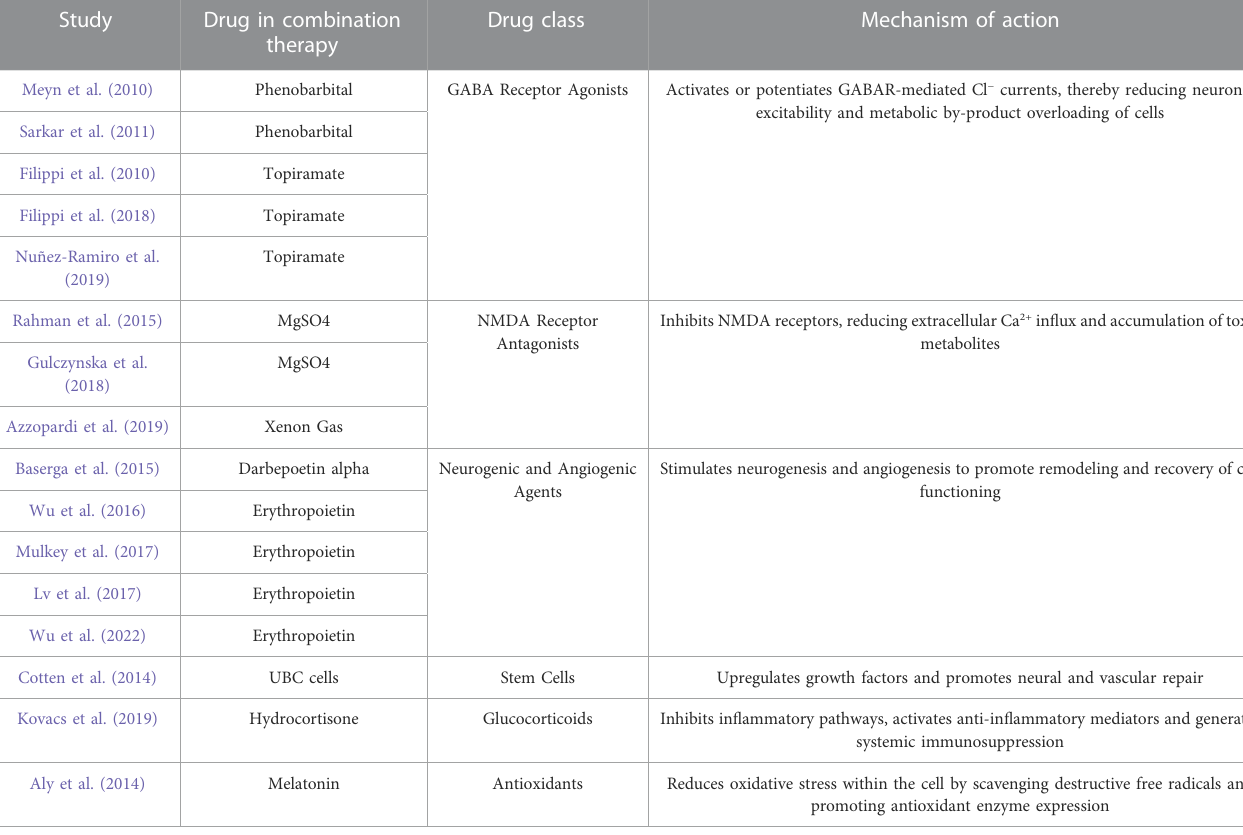
TABLE 2 Study subgroups. Classi fi cation based on drug class of the therapeutic agent in the combination therapy